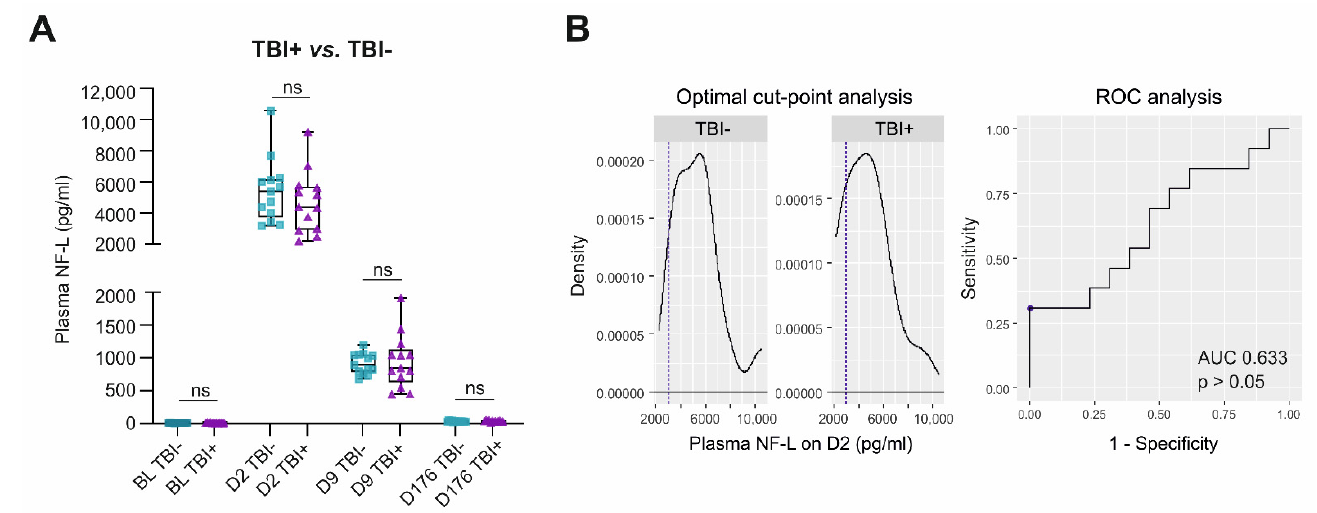
Figure 6. Plasma NF-L and epileptogenesis after TBI. ( A ) Box and whisker plots (whiskers: minimum and maximum; box: interquartile range; line: median) showing plasma NF-L levels ( y -axis) in different groups and time-points ( x -axis). Plasma NF-L levels on D2, D9, or D176 did not differ between rats that did (TBI+, n = 13) or did not develop epilepsy (TBI − , n = 13, p > 0.05). ( B ) Plasma NF-L levels on D2, D9, or D176 did not distinguish TBI+ and TBI − rats in the ROC analysis ( p > 0.05, results for D2 shown in the figure). Statistical significance: ns, not significant (Mann-Whitney U test). Abbreviations: AUC, area under the curve; BL, baseline; D2, day 2 post-TBI; D9, day 9; D176, day 176; NF-L, neurofilament light chain; ROC, receiver operating characteristics.